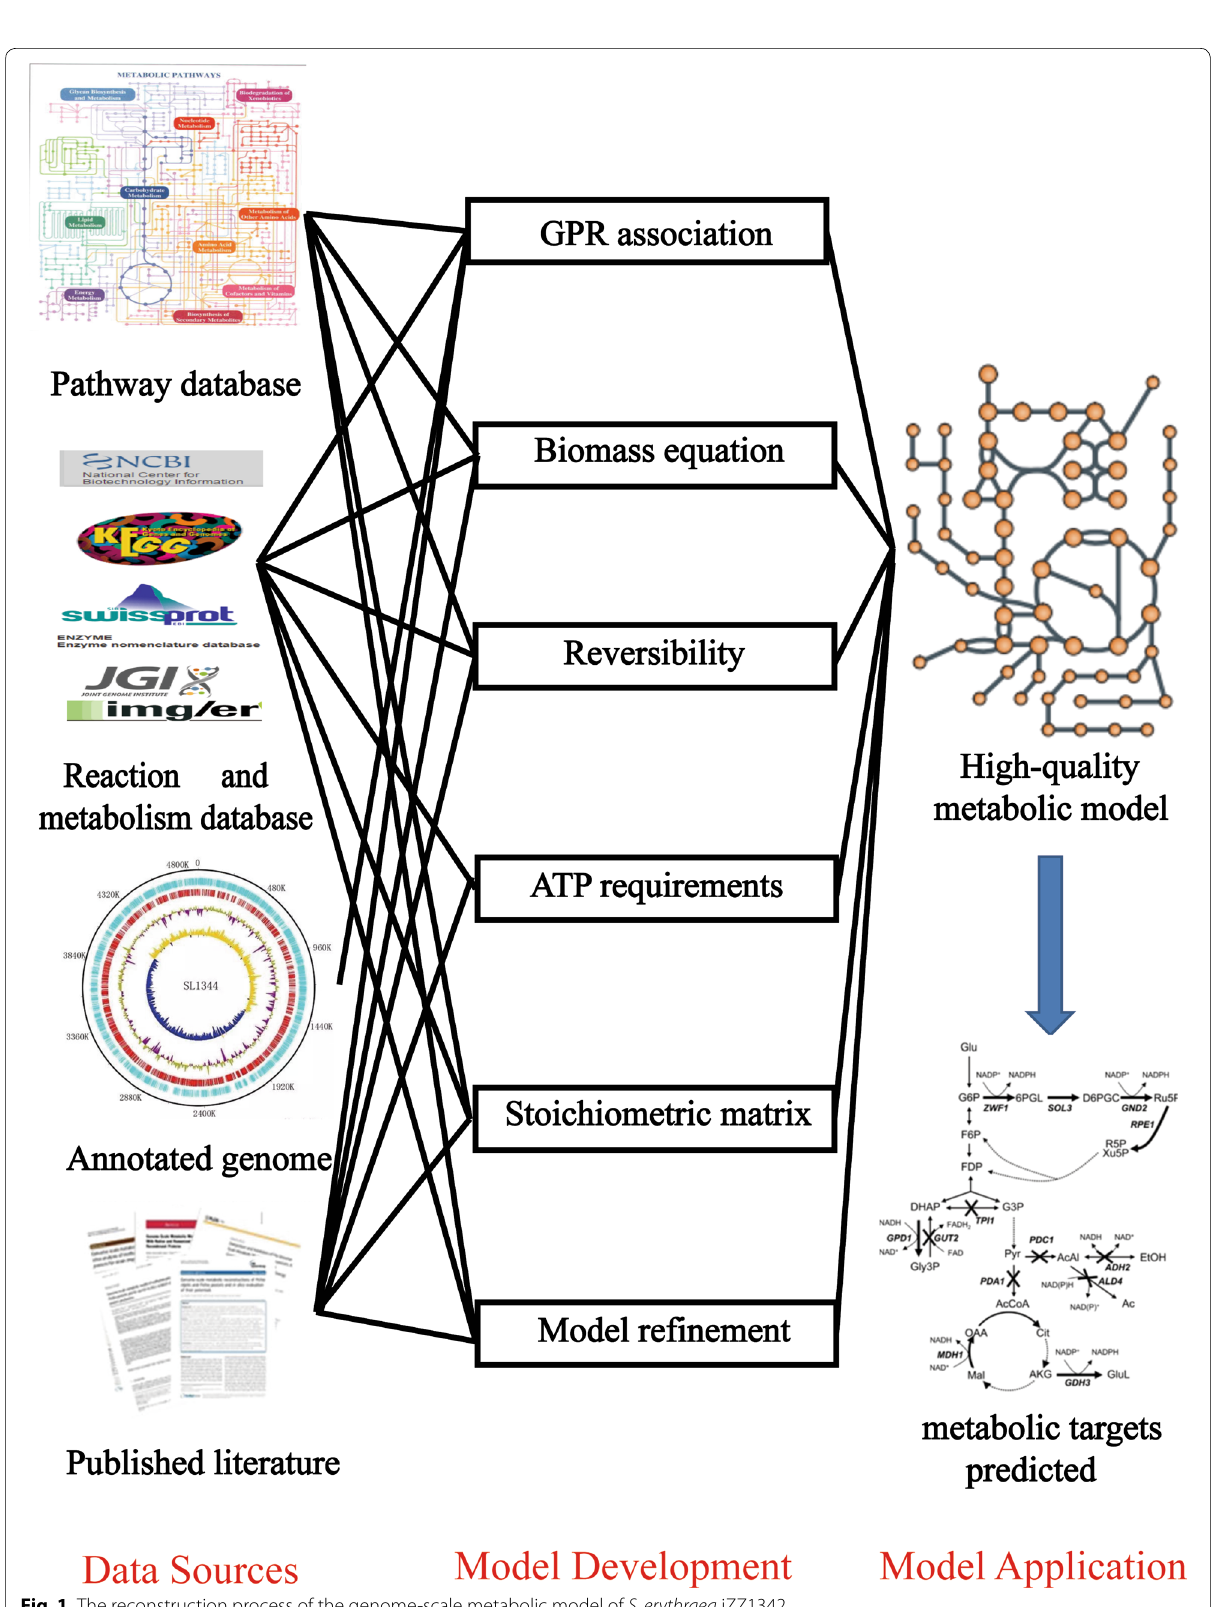
Fig. 1 The reconstruction process of the genome-scale metabolic model of S. erythraea